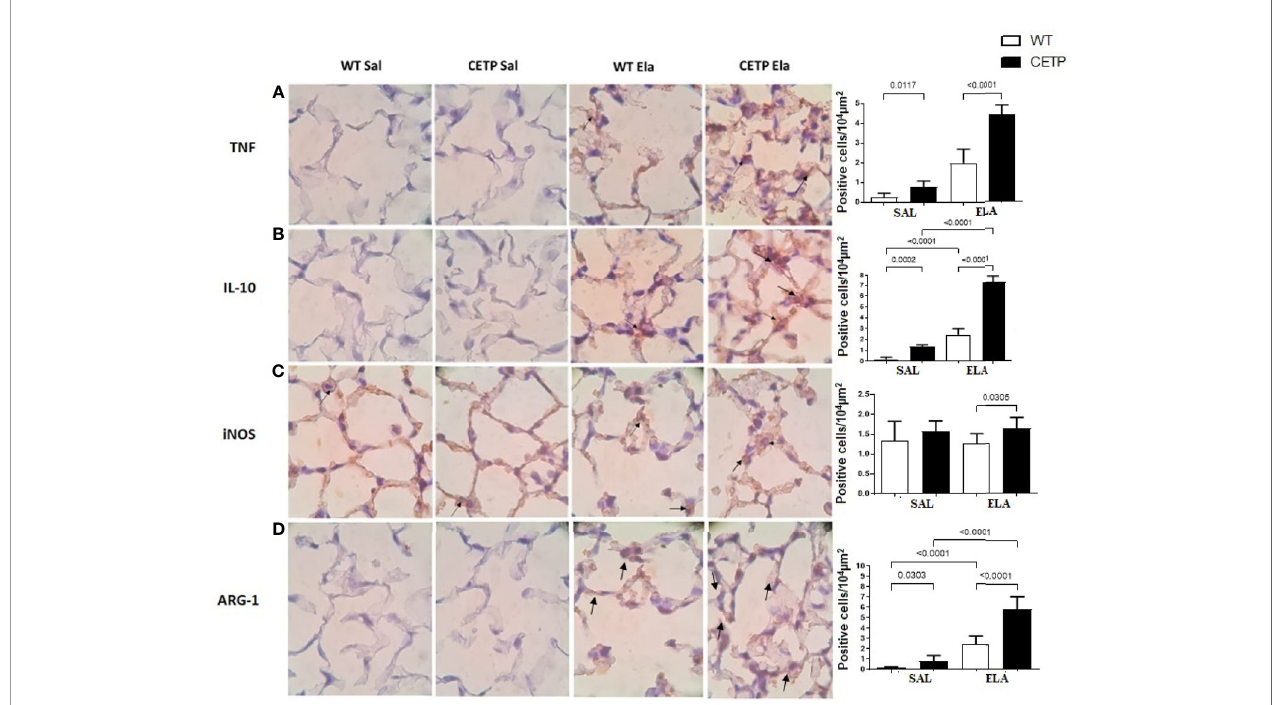
FIGURE 11 | Photomicrograph of stained slides for immunohistochemistry analysis of in fl ammatory markers from WT and CETP Tg mice and from huCETP mice after elastase-induced emphysema (ELA) or saline (SAL). TNF (A) , IL-10 (B) , iNOS (C) and Arginase 1 (D) . Representative images of micrographs at ×1,000 magni fi cation. Values were expressed as mean and standard deviation. These data were analyzed by ANOVA with two-stage linear step-up procedure of Benjamini, Krieger, and Yekutieli post-test. p < 0.01: (n =